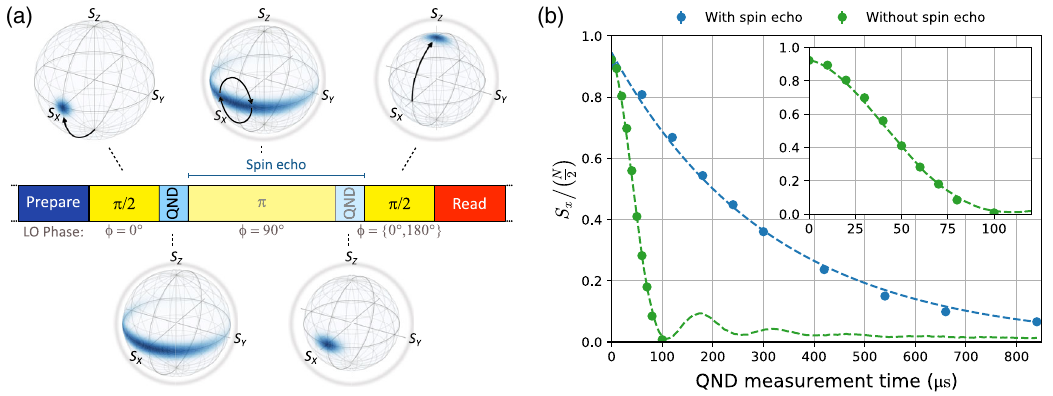
FIG. 2. Coherence preservation after the QND measurement. (a) Timing sequence used to measure coherence after QND measurement, and sketches of the atomic state in the Bloch sphere representation at each step of the sequence. The projection of atoms into the ground or excited state due to scattering of QND probe photons is represented by the shrinking radius of the Bloch sphere compared to its original size N= 2 (gray halo). The final Bloch sphere (top right) shows the case where the final π = 2 -pulse phase is ϕ ¼ 0 °. (b) The measured atomic coherence S remaining after QND measurement as a function of total probe time. For the data with x spin echo we use the total measurement time summed over the two QND probes, and fit an exponential decay with time constant 317 μ s (blue dashed line). The model for coherence decay without spin echo (green dashed line, also displayed in the inset) is described in the main